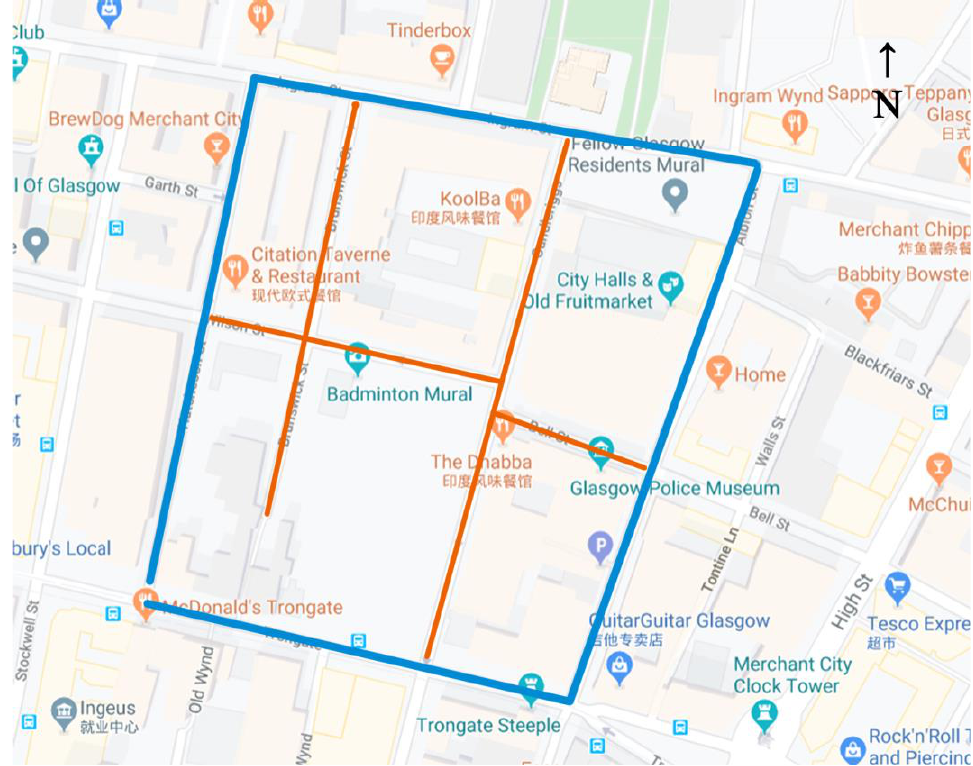
Figure 1. Experimental area: the blue box represents the experimental area; the orange lines represent roads. Since the participants’ native language is Chinese, the map used in the experiment had some Chinese annotations.